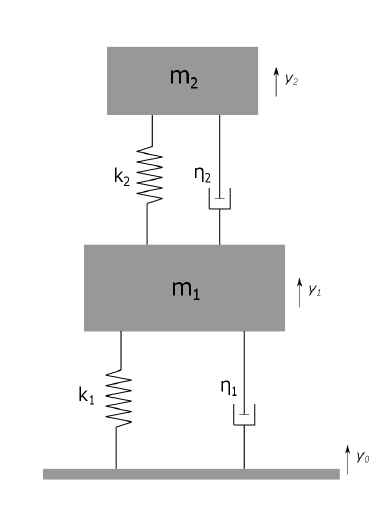
Figure 2. Typical lumped equivalent mass–spring–damper model for two-degree-of-freedom (2DOF) cantilever